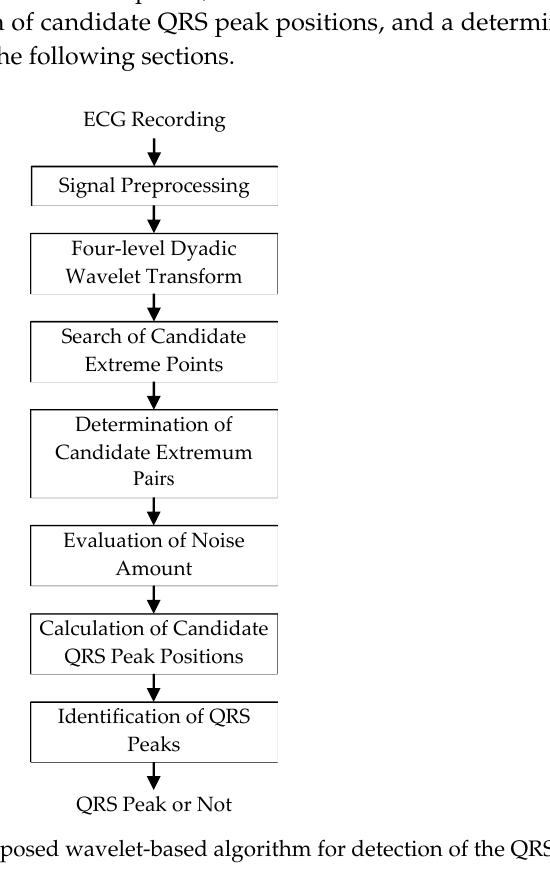
Figure 1. Block diagram of the proposed wavelet-based algorithm for detection of the QRS complex.